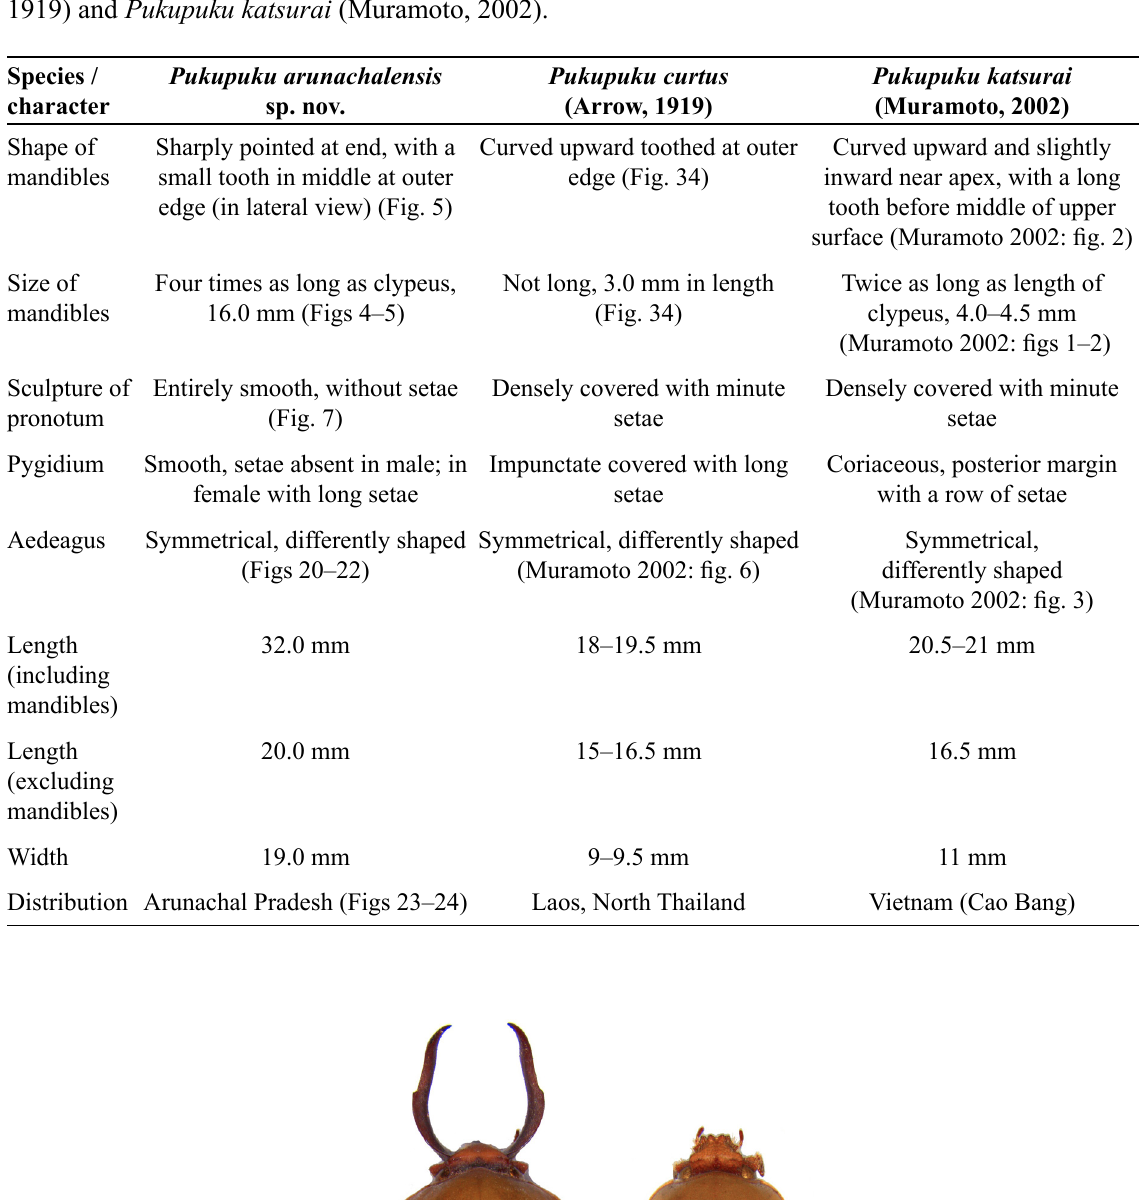
Table 1. Differential characters (males) of Pukupuku arunachalensis sp. nov., Pukupuku curtus (Arrow, 1919) and Pukupuku katsurai (Muramoto,